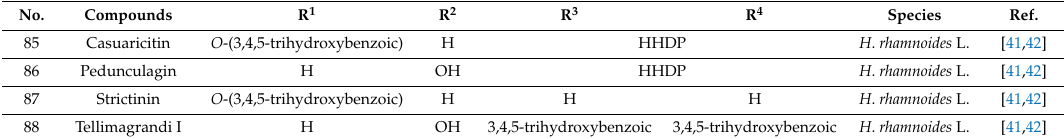
Figure 6. Chemical structures of others from Hippophae species. Table 3. Others from Hippophae species. Table 4. Others from Hippophae species.